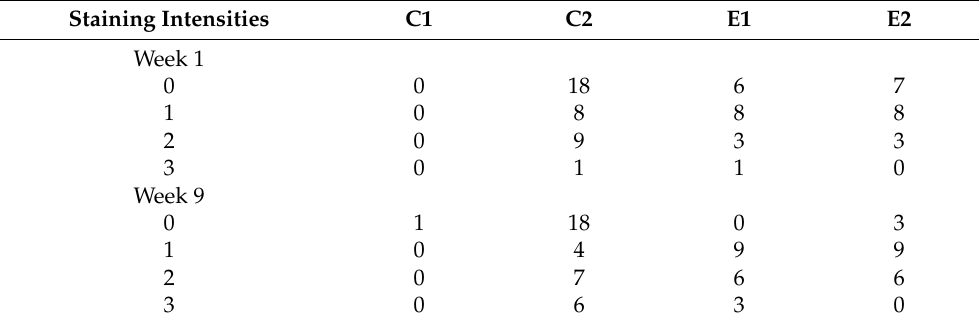
Table 4. Staining intensity frequencies in the four experimental groups analyzed by fecal blood test. Staining Intensities